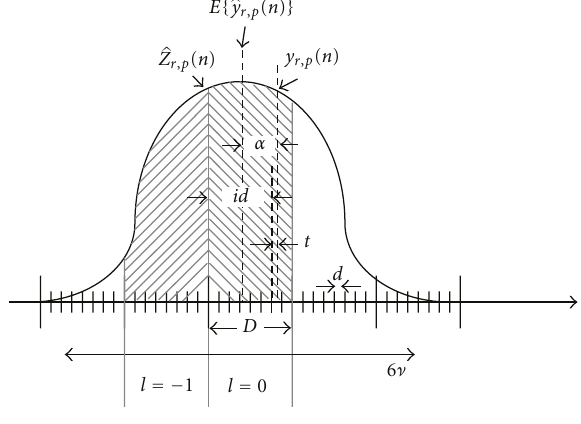
Figure 6: Quantization error distribution.